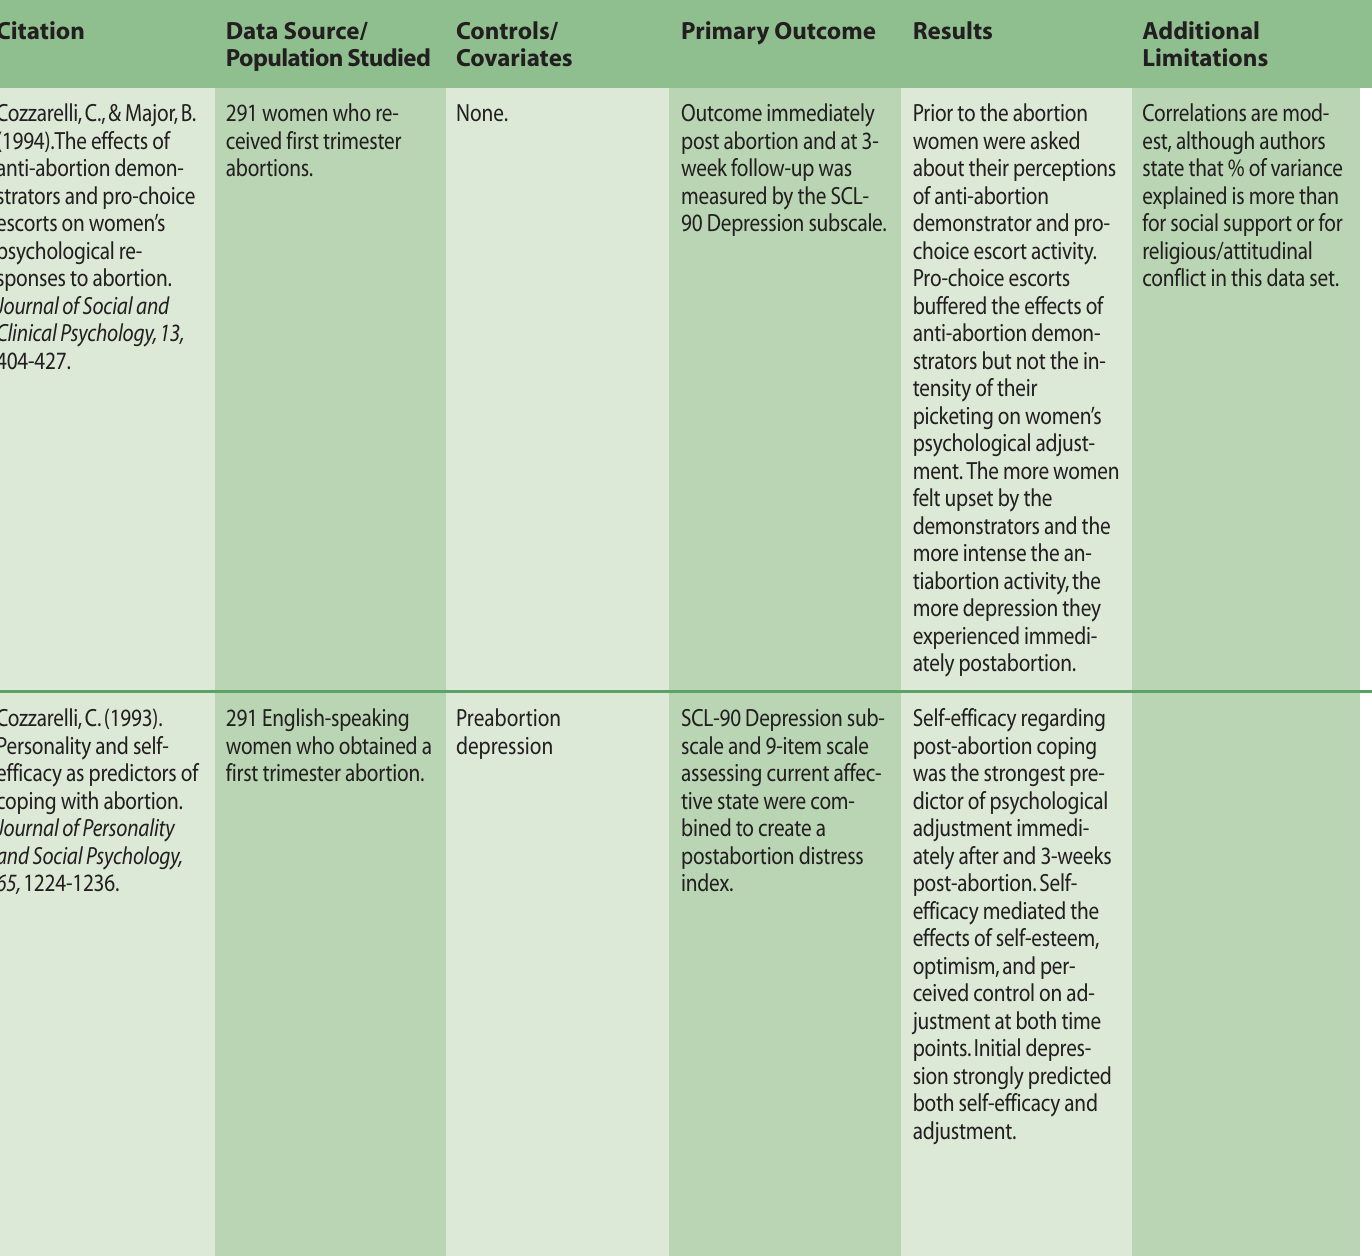
Table 5: U.S.Samples of Abortion Group(s) Only/No Comparison (continued) Prospective Analysis Using Major & Colleagues 1-Site